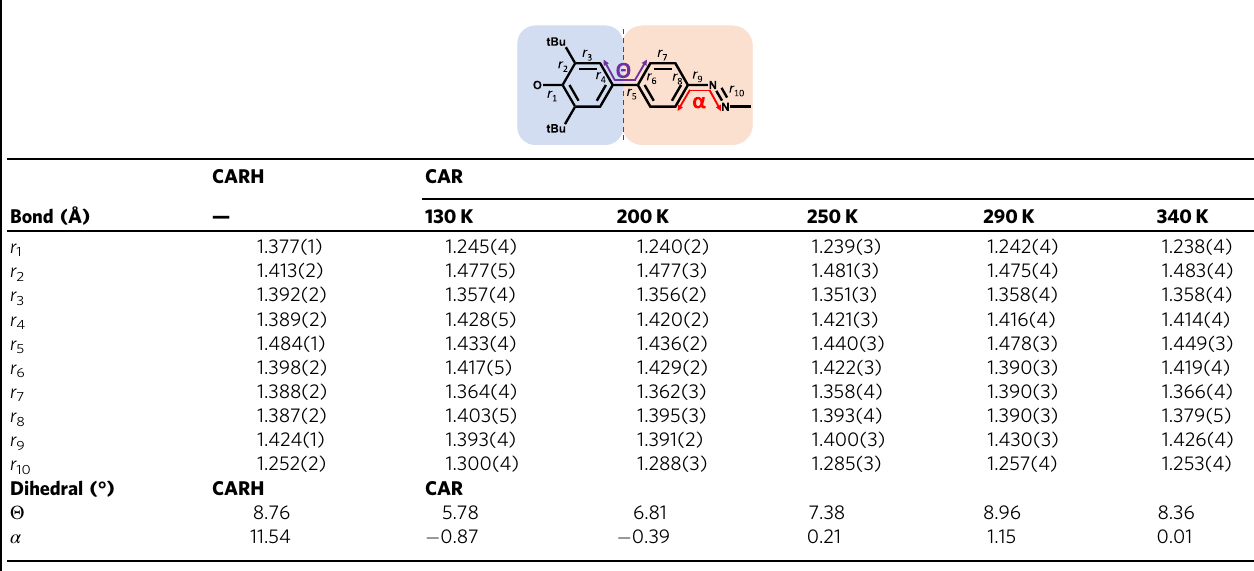
Table 1 Selected bond lengths (Å) and dihedral angles at different temperatures of CARH and CAR.